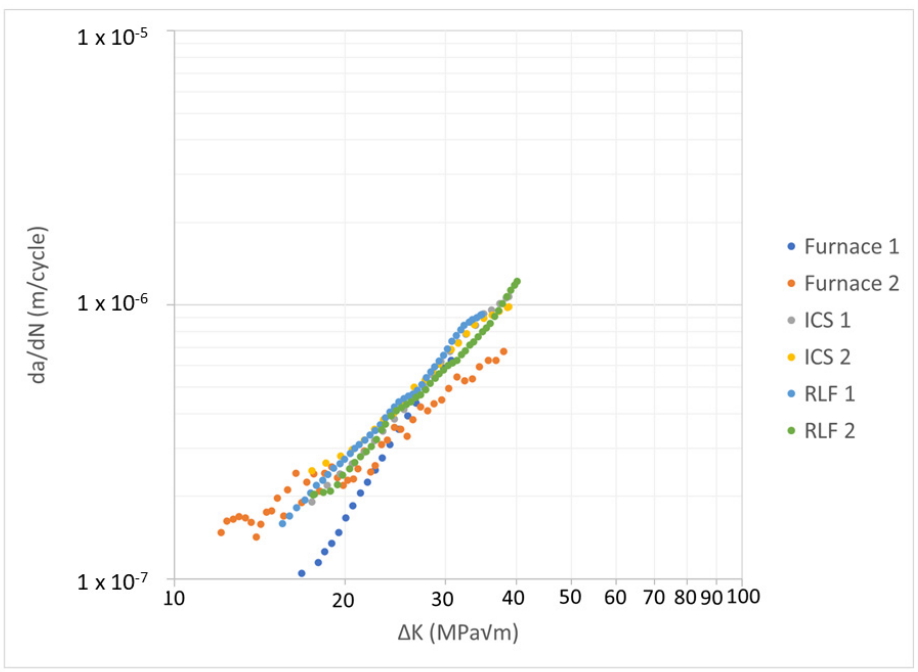
Figure 7. Paris curves comparing isothermal tests conducted using a conventional furnace, ICS and RLF. Tests conducted at 500 °C, 500 MPa, R = 0 and frequency of 0.25 Hz.